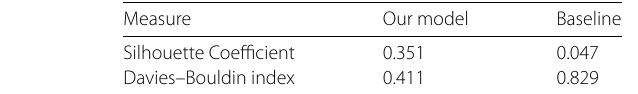
Table 4 Evaluation of clustering results